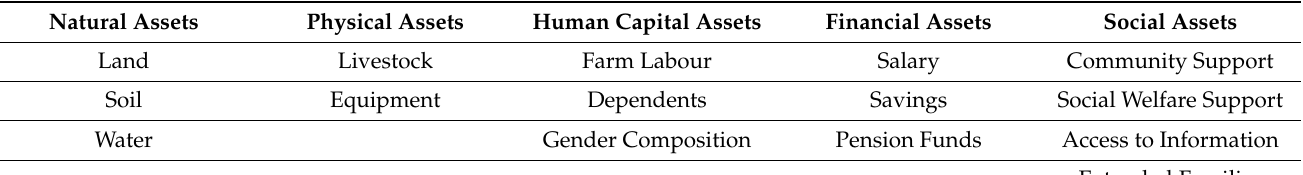
Table 2. Five sustainable livelihood indicators (adapted from [27]).